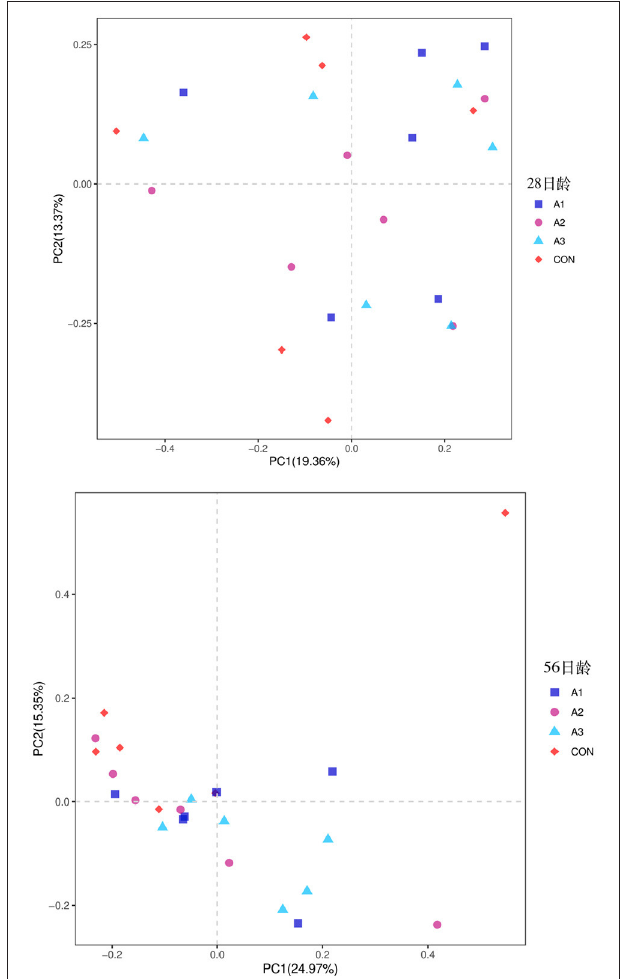
FIGURE 2 | Principal Coordinate Analysis (PCoA) of fecal bacterial community structures of suckling calves in the four groups at 28 days of age (left) and 56 days of age (right). CON, the dosage of B4 is 0mg / day; A1, the dosage of B4 is 15mg / day; A2, the dosage of B4 is 30mg / day; A3, the dosage of B4 is 45mg /